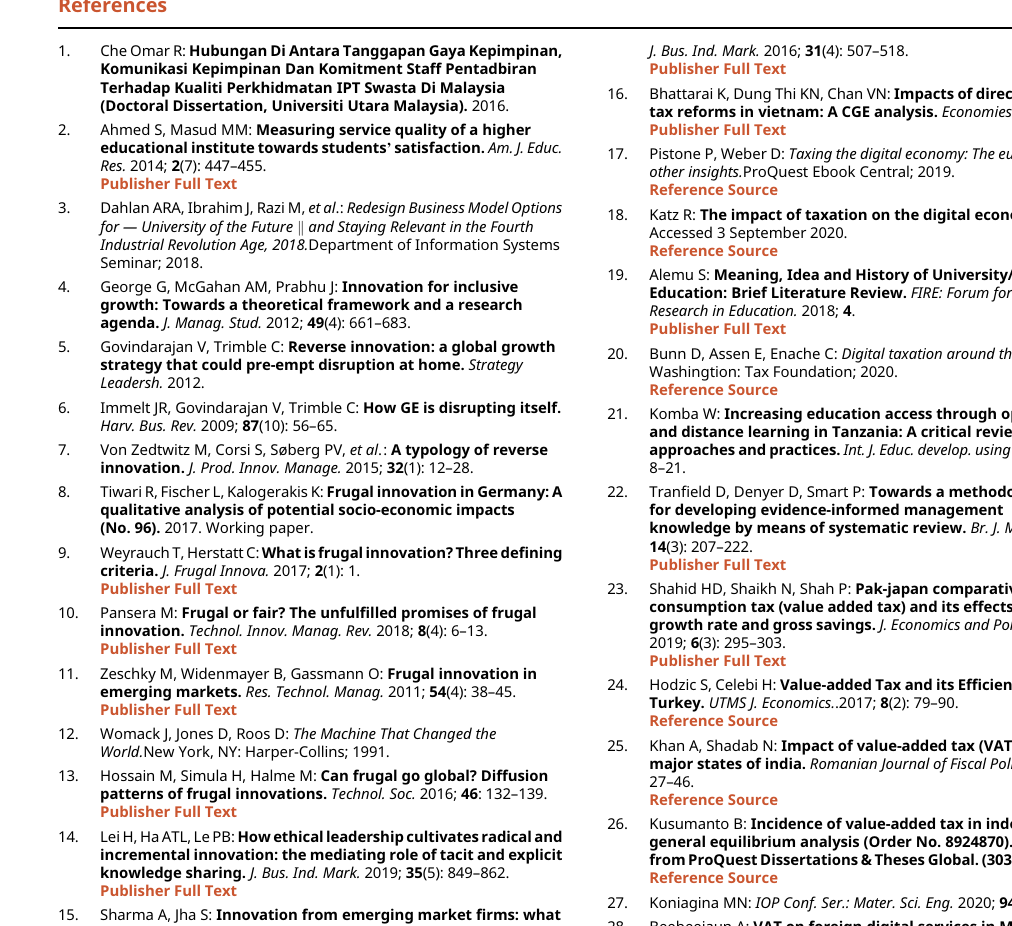
Figshare: Data File – Digital Taxation.xls, https://doi.org/10.6084/m9.figshare.16722904.v2. 32